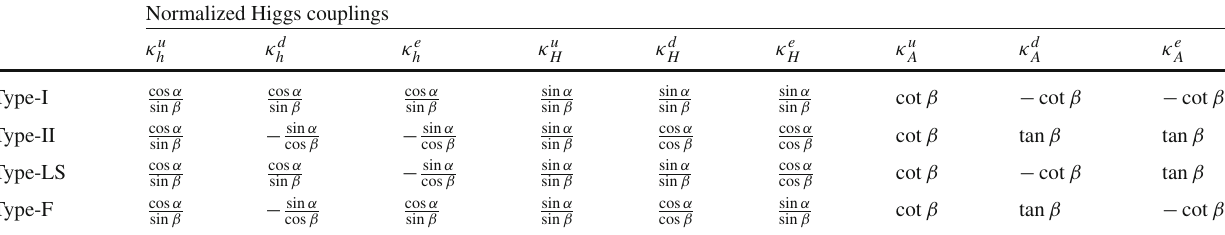
Table 2 Higgs couplings to the SM fermions in the four different types of 2HDM, normalized to the corresponding SM values Normalized Higgs